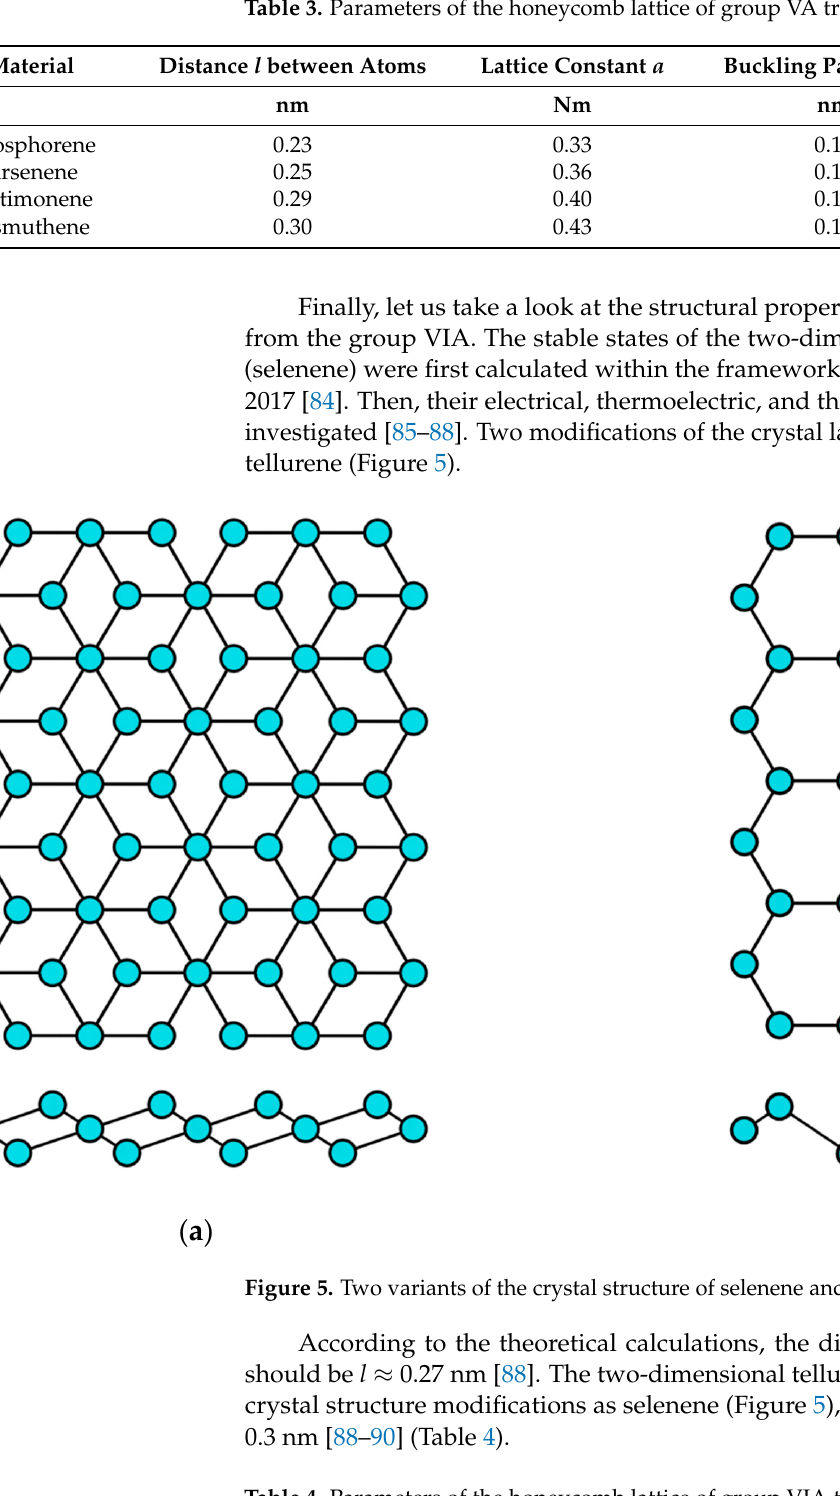
Table 3. Parameters of the honeycomb lattice of group VA transgraphenes.